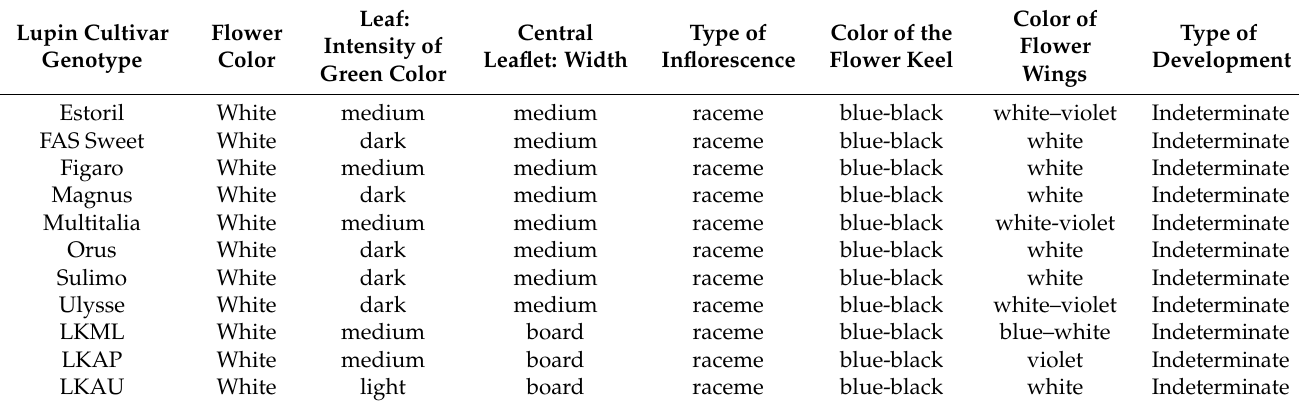
Table 4. Phenotypic data referring to the type of development and related traits.